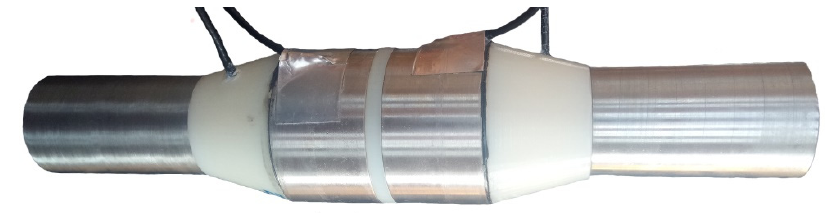
Figure 5. Image of the experimental device.